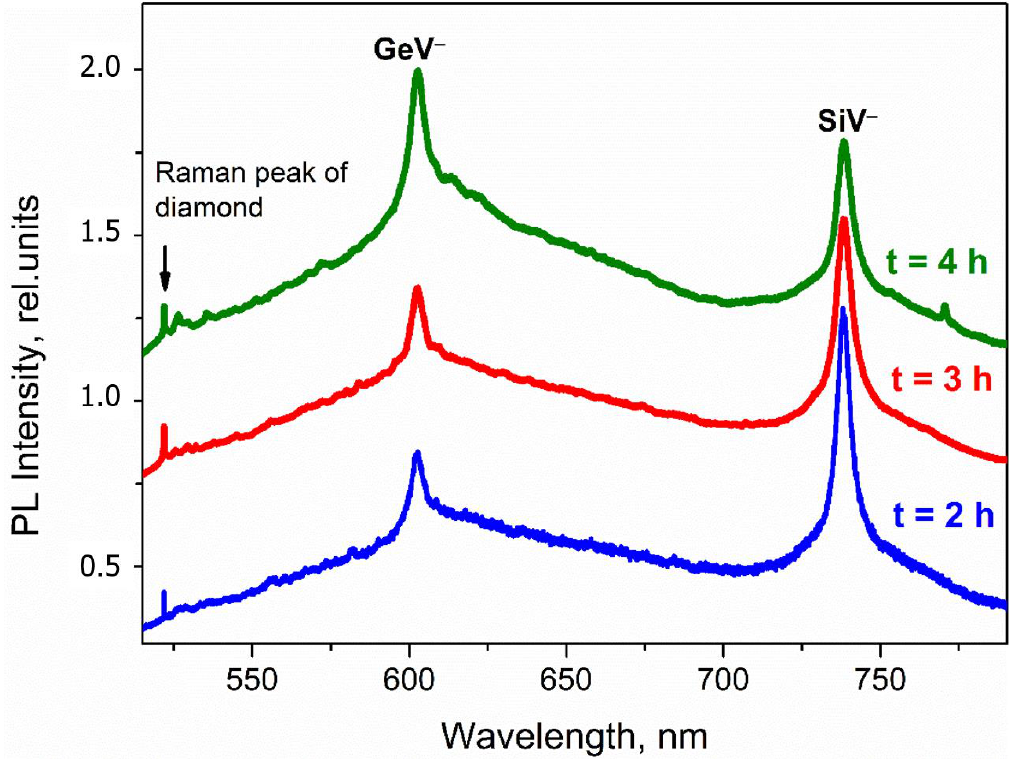
Figure 4. Photoluminescence spectra of nanodiamonds obtained over a growth time of 2, 3, 4 h. The substrate temperature — 700 °С; the methane concentration— 4%. The substrate temperature—700 ◦ C; the methane